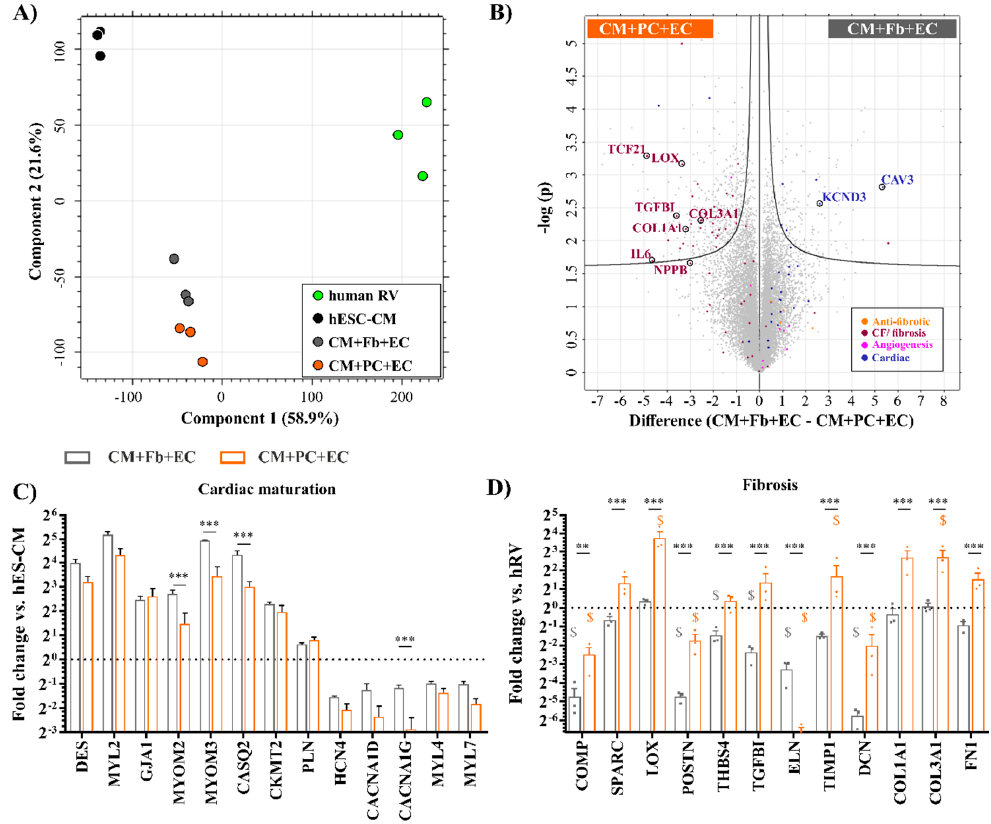
Figure 5. BCTs with iPSC-PCs exhibit the molecular signatures of myocardial interstitial fibrosis. ( A ) PCA plot showing the first two principal components. ( B ) Vulcano plot showing differences in gene expression between CM+PC+EC and CM+Fb+EC BCTs. The areas above the black curves contain significantly upregulated genes on both sides. Expression of cardiac maturation-related genes ( C ) in BCTs normalized to hESC-CMs (all genes in C are significant vs. hESC-CMs) and fibrosis-related ( D ) genes normalized to hRV genes significant vs. hRV are marked by $; ** p < 0.01 *** p < 0.001 between indicated groups; n = 3 in each group. hRV—human right ventricle.